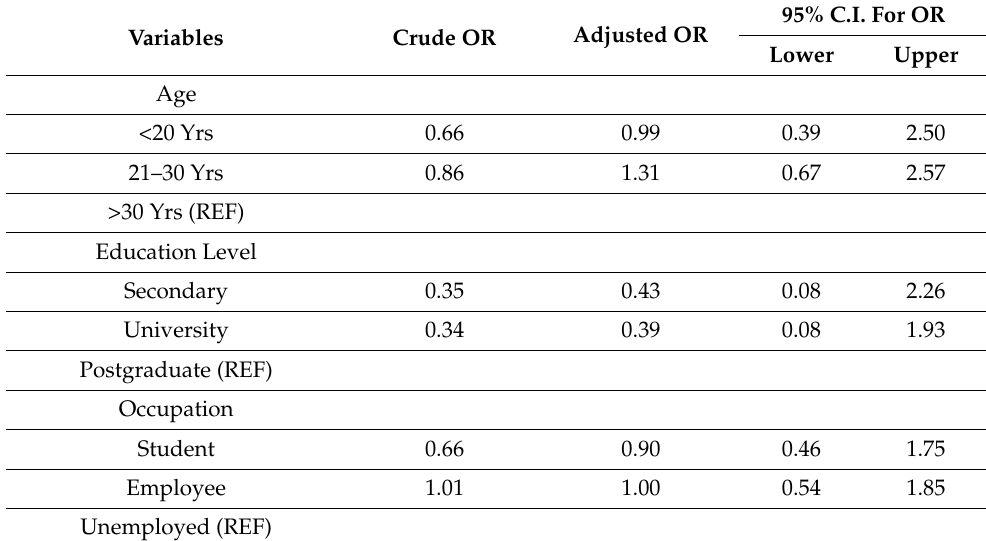
Table 4. Univariate and multivariate logistic